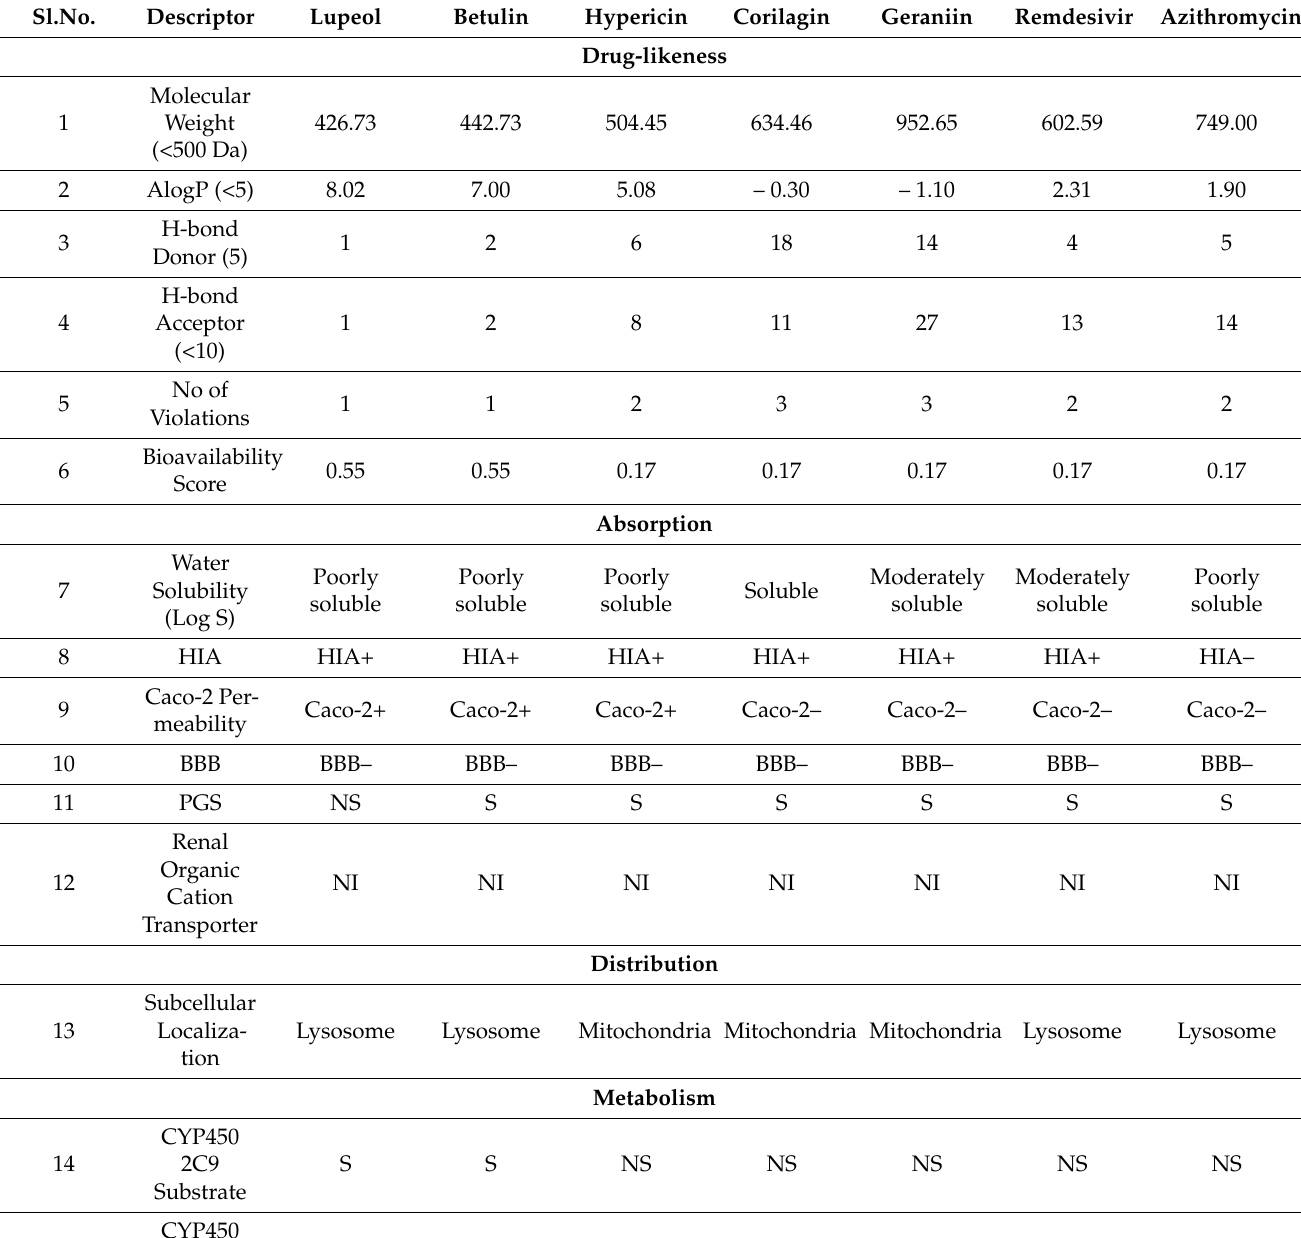
Table 5. Drug-likeness and ADMET predicted for the selected antiviral inhibitors using SwissADME and